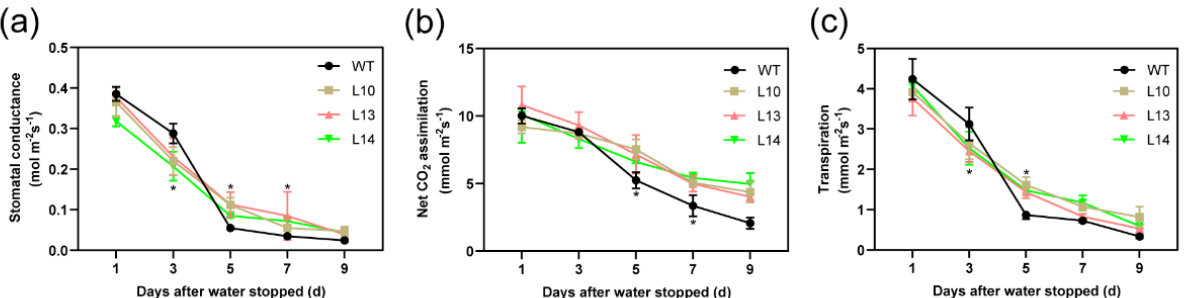
Figure 4. Parameters of poplars during nine days of water deficit. ( a ) Stomatal conductance, ( b ) Net CO 2 assimilation, and ( c ) Transpiration. Each treatment was performed with three biological replicates (n = 3), and values are means ± SE. Data were analyzed with the Student’s t -test in the ANOVA program of SPSS (IBM SPSS17.0). * indicates a significant difference compared with the control ( * p < 0.05).